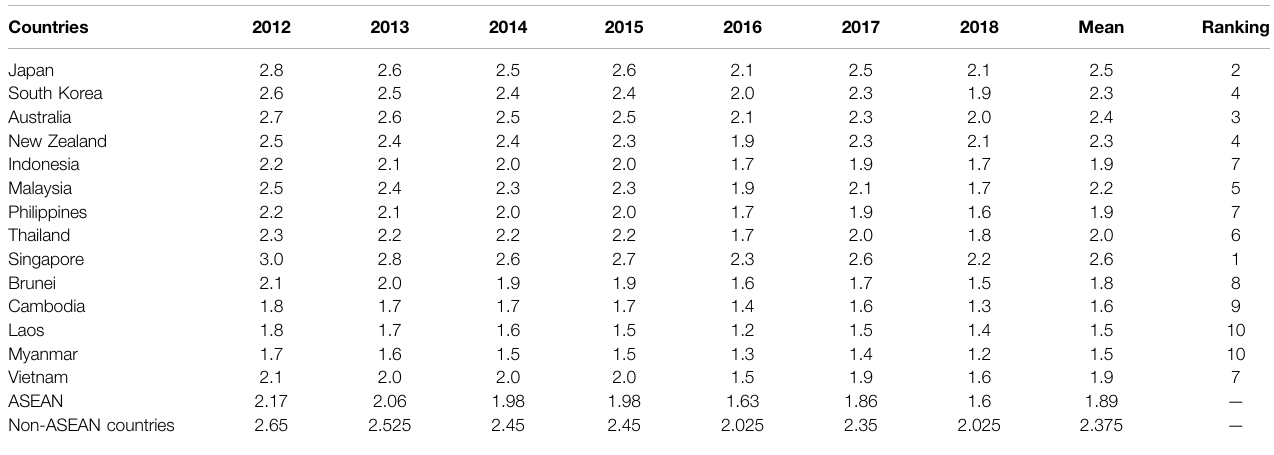
TABLE 3 | Performance of green logistics in RCEP14 countries during 2012 – 2018.